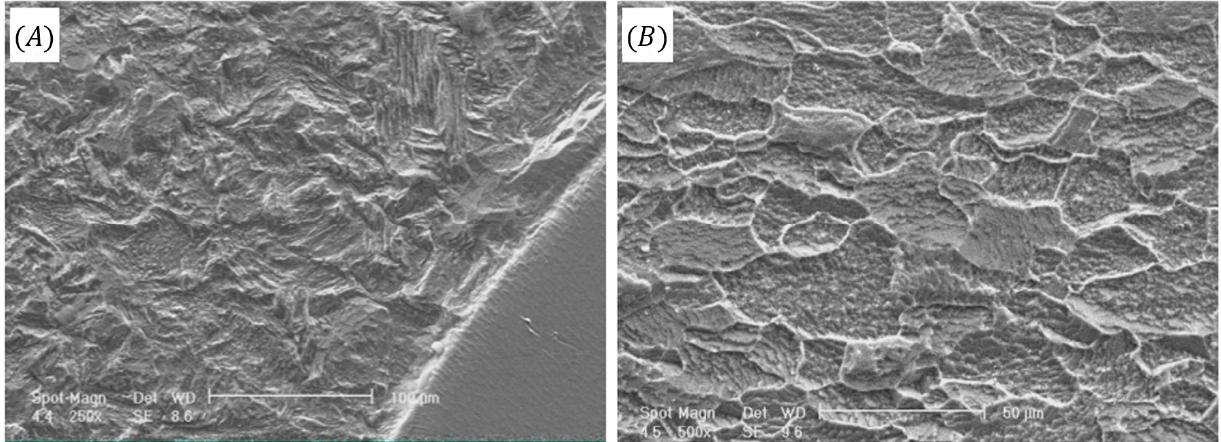
Figure 13. Scanning electron microscopy images of the ( a ) martensite phase region ( b ) pearlite-ferrite phase in HAZ carbon steel.